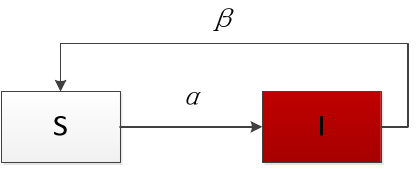
Figure 4. Status of nodes in the cyber-physical power system. S indicates that the node is in a normal operating (susceptible) state, I indicates that the node is in a failure (infected) state, the probability of failure propagation (being infected) is α , and the probability of resuming operation (being cured) is β